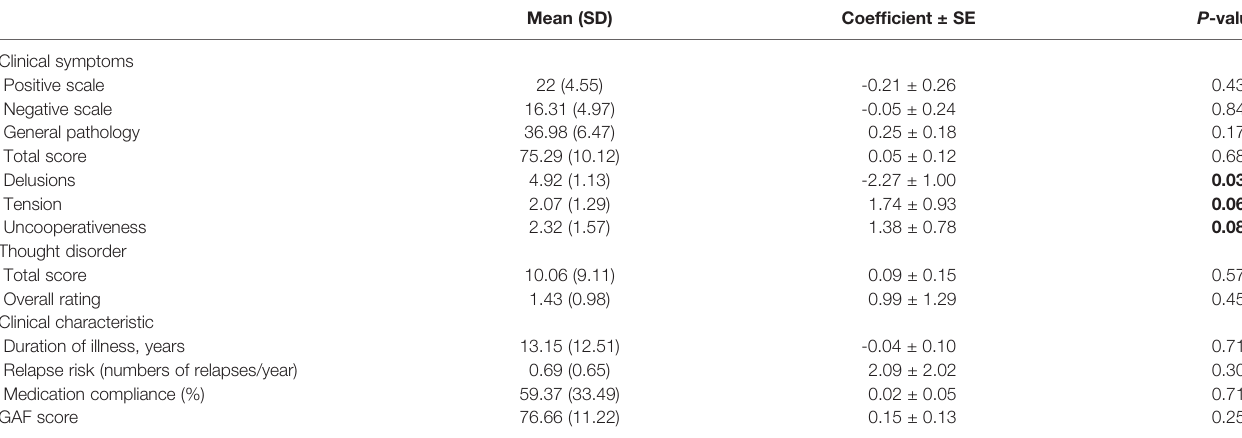
TABLE 4 | Association of HCC with clinical symptoms and characteristics in